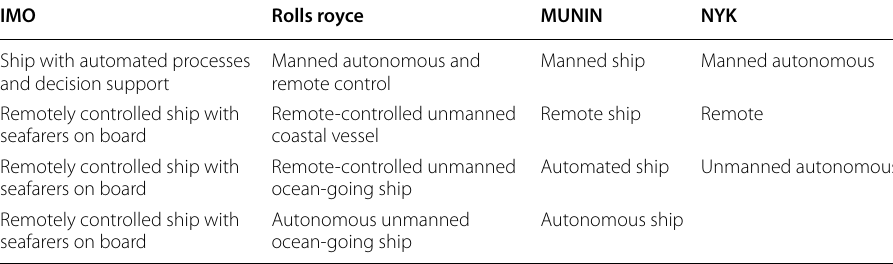
IMO Rolls royce MUNIN NYK